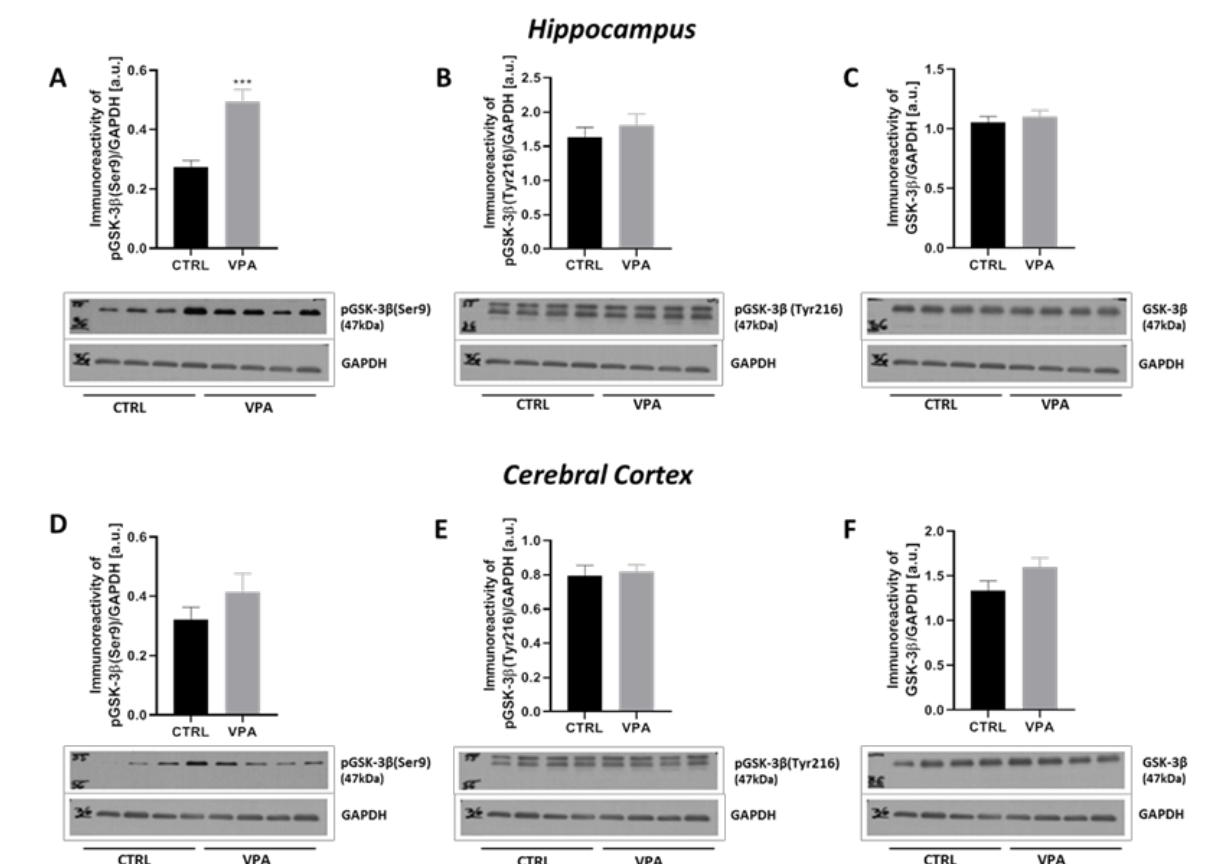
Figure 9. The effect of prenatal exposure to VPA on the GSK-3β in the rat brain. The phosphorylation status of GSK-3β at (Ser9) and (Tyr216) as well as the immunoreactivity of total GSK-3β in control and VPA-exposed rats were monitored using Western blot analysis. Densitometric analysis and representative pictures of pGSK-3β(Ser9), pGSK-3β(Tyr216) and total GSK-3β in the hippocampus ( A – C ) and cerebral cortex ( D – F ) were shown. Results were normalized to GAPDH levels. Data represent the means ± S.E.M. from n = (8–10) independent experiments in the hippocampus: ( A ) n = 8 (CTRL), n = 8 (VPA); ( B ) n = 10 (CTRL), n = 8 (VPA); ( C ) n = 10 (CTRL), n = 9 (VPA); and n = (7–9) in the cerebral cortex: ( D ) n = 7 (CTRL), n = 7 (VPA); ( E ) n = 9 (CTRL), n = 7 (VPA); ( F ) n = 9 (CTRL), n = 7 (VPA). *** p < 0.001, vs. control.